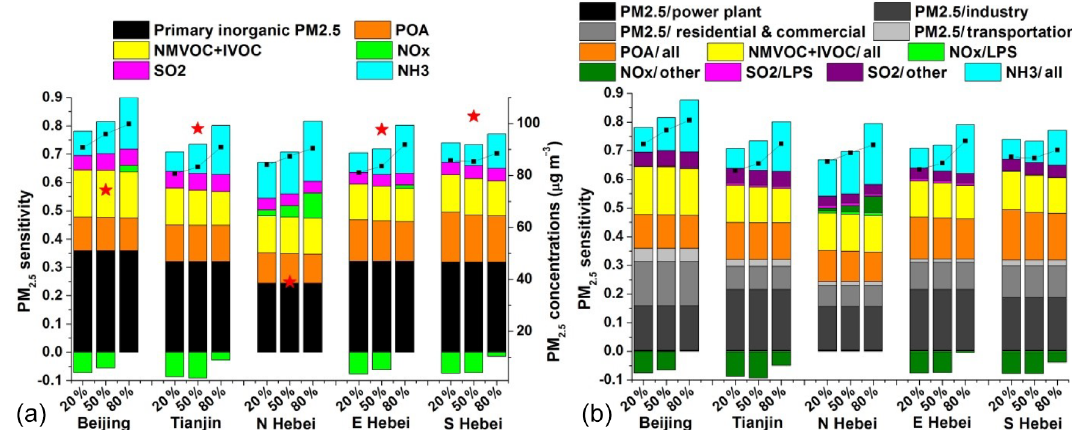
Figure 4. Sensitivity of 4-month mean PM 2 . 5 concentrations to the stepped control of individual air pollutants (a) and individual pollutant– sector combinations (b) . The x axis shows the reduction ratio (1 − emission ratio). The y axis shows PM 2 . 5 sensitivity, which is defined as the change ratio of concentration divided by the reduction ratio of emissions. The colored bars denote the PM 2 . 5 sensitivities when a particular emission source is controlled while the others stay the same as the base case; the black dotted line denotes the PM 2 . 5 sensitivity when all emission sources are controlled simultaneously. The red stars represent PM 2 . 5 concentrations in the base